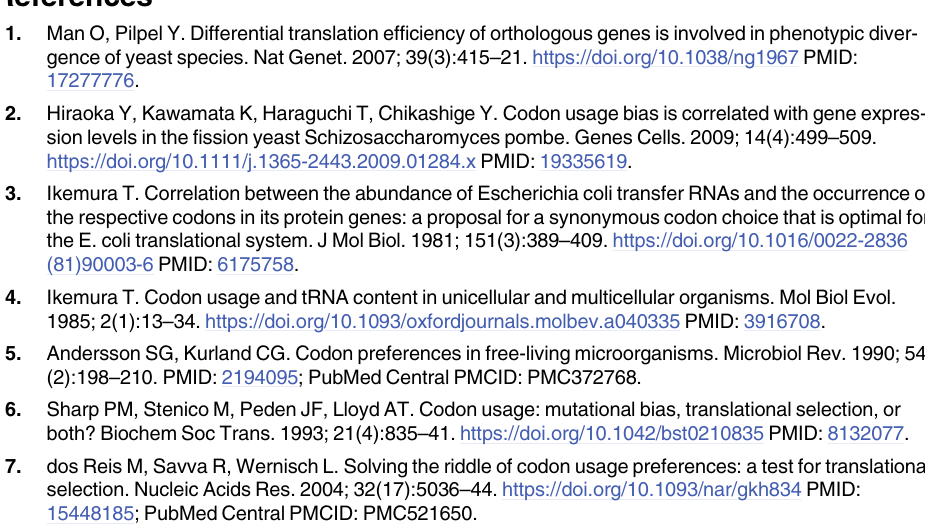
S8 Table. For each position (distance from the stop codon, columns) and for every species, we computed the Kruskal-Wallis (FDR corrected) p-value, measuring the difference in the distribution of RSCA values between replaceable, non-replaceable, and non-fragile that end by A/T. S9 Table. For each position (distance from the stop codon, columns) and for every species, we computed the Kruskal-Wallis (FDR corrected) p-value, measuring the difference in the distribution of RSCA values between replaceable, non-replaceable, and non-fragile codons that end by C/G. S10 Table. Median minimum free energy (MFE) at the 3’-end (observed MFE), median MFE expected by the global (not spatial) codon bias (expected MFE), and p-value for test- ing whether the median difference between pairs of expected and observed values equals zero (FDR-corrected two-sided sign